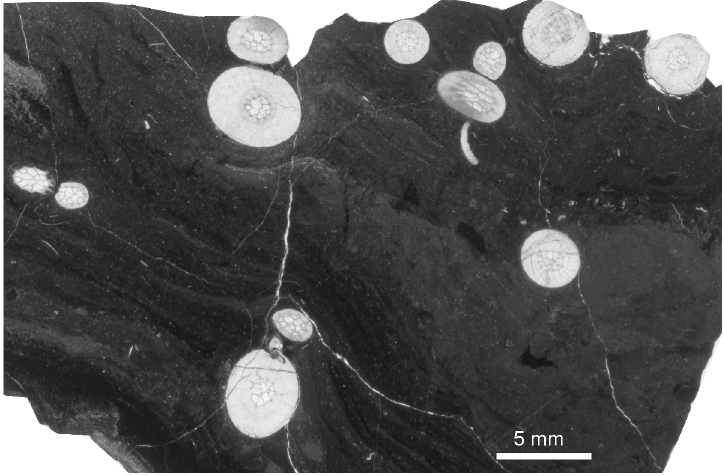
Fig 10. Heterocorals Oligophylloides co-occurring with Thamnoptychia mistiaeni sp. nov. Transverse sections through branches. Kowala Quarry, lithological sets J or K, Upper Famennian.